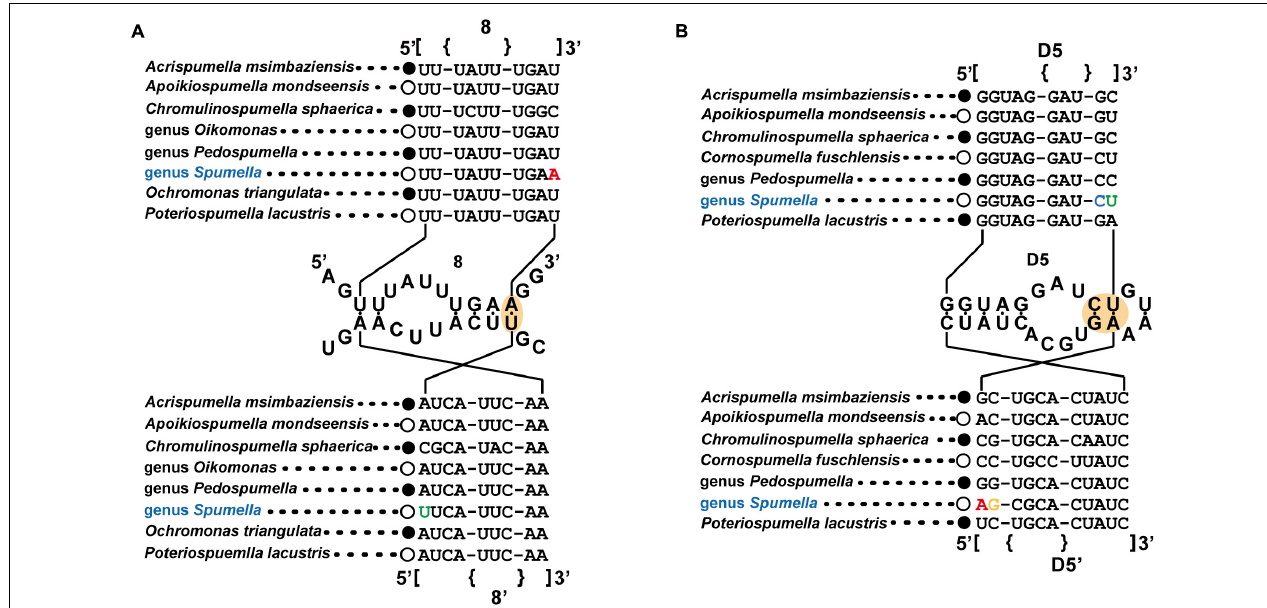
FIGURE 2 | Molecular signatures of the nuclear SSU (A) and LSU (B) rRNA differentiating the genus Spumella from other non-photosynthetic chrysophytes. The secondary structure was constructed based on the genus Spumella . The nomenclature of nucleotides and base pairs depends on the polarity of the DNA: increasing numbers generally indicate the 5 (cid:48) –3 (cid:48) direction. [] indicates the beginning and end of the stem, with {} indicating non-binding (loops, bulges) of the base